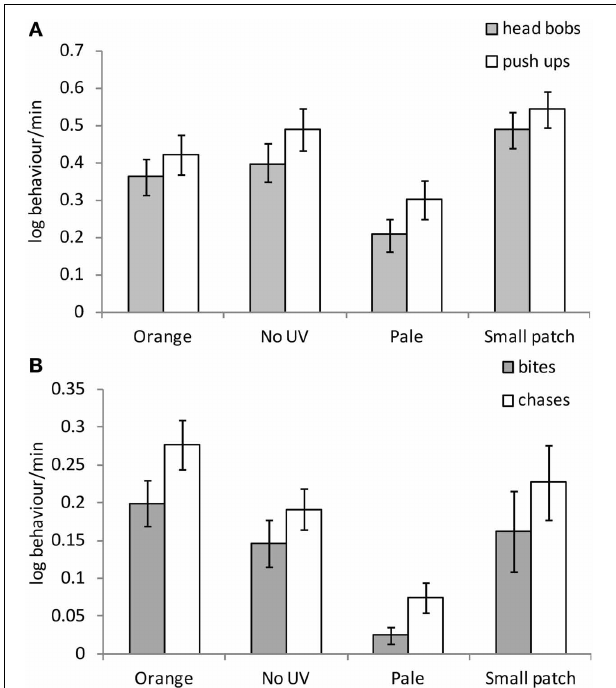
FIGURE 5 | Mean ( ± SE ) (A) male courtship and (B) harassment toward females with differing manipulated patch treatments on non-receptive